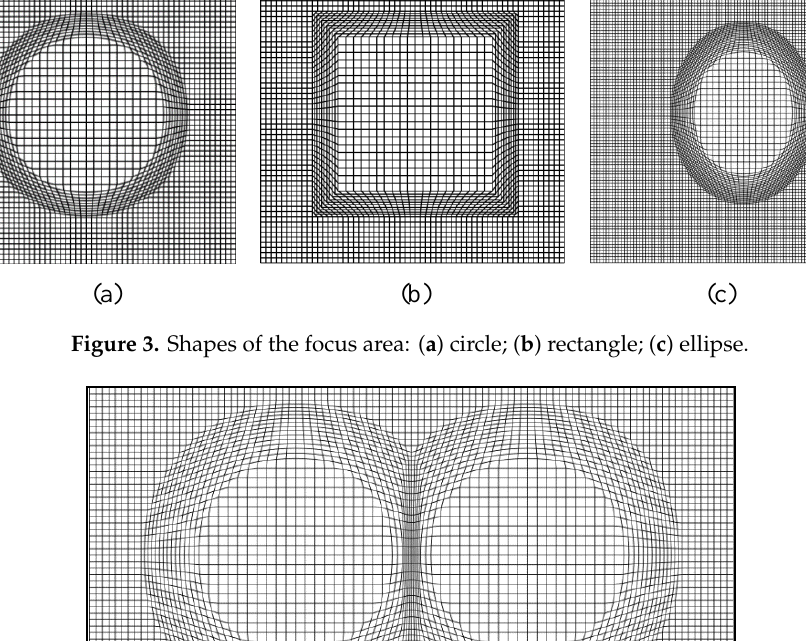
Figure 3. Shapes of the focus area: ( a ) circle; ( b ) rectangle; ( c ) ellipse.